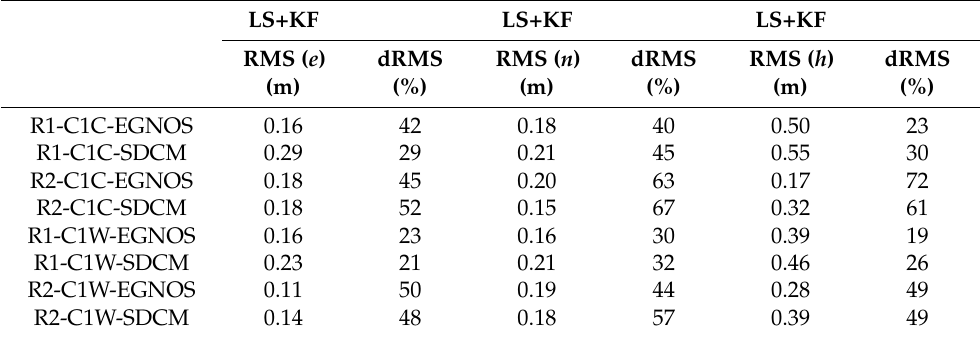
Table 2. Average RMS errors for EGNOS and SDCM positioning as well as for codes C1C and C1W, additionally using Kalman filtering.